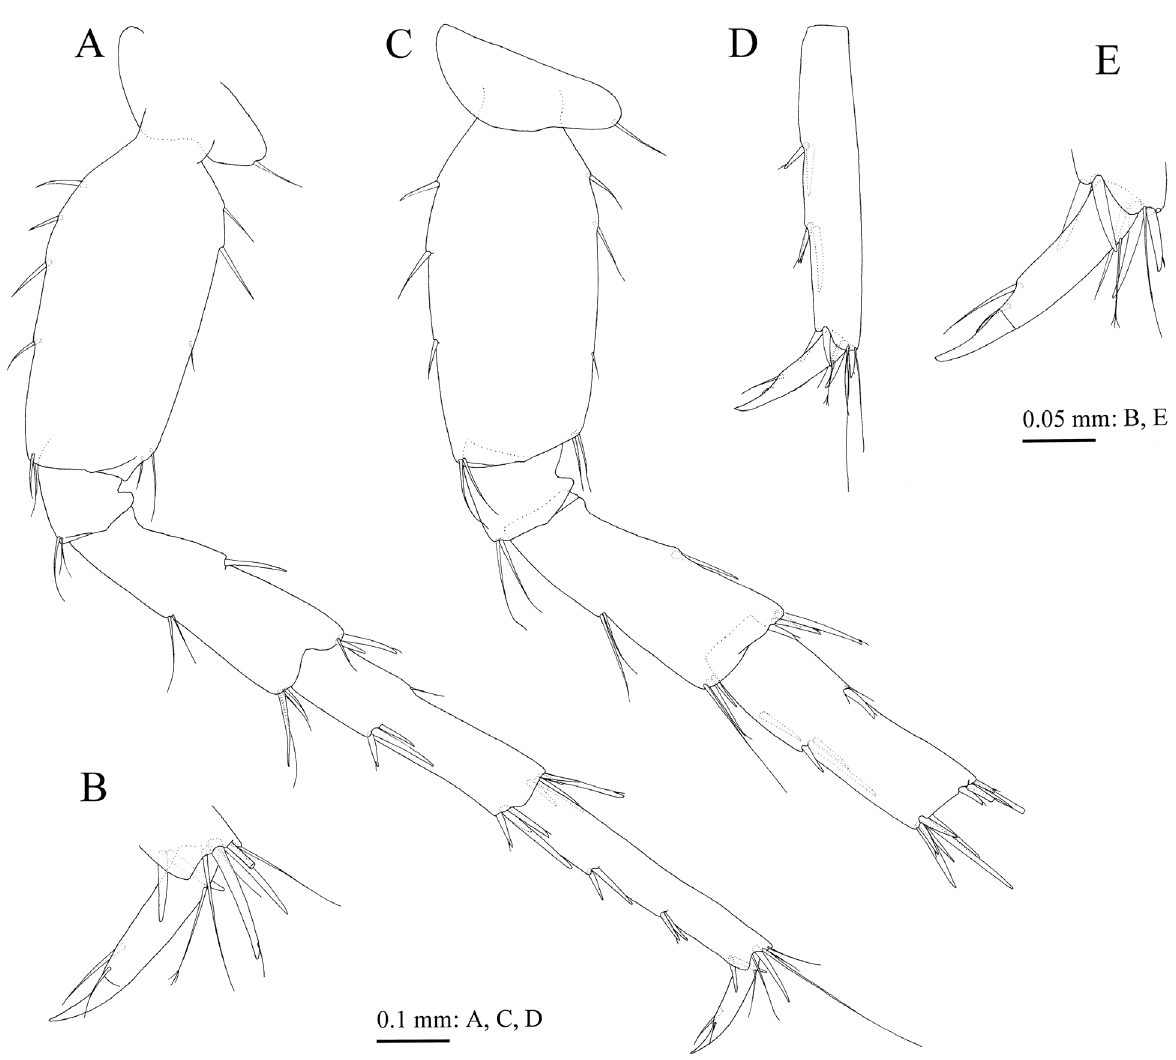
Figure 6. Pseudocrangonyx gudariensis Tomikawa & Sato, sp. n., holotype, male (3.9 mm), NSMT-Cr 24603. A pereopod 6, lateral view; B dactylus of pereopod 6, lateral view; C coxa–carpus of pereopod 6, lateral view; D propodus–dactylus of pereopod 6, lateral view; E dactylus of pereopod 7, lateral